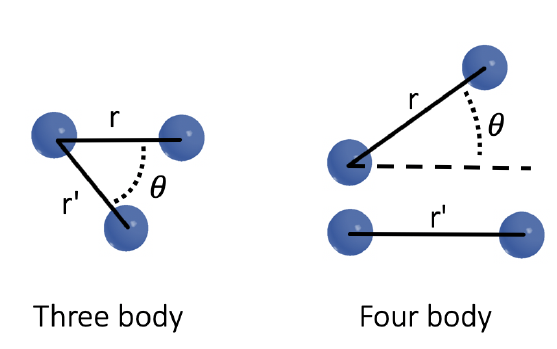
Figure 1. Geometry of three- and four-body correlations. The definition of the atomic coordinates in the pair-angle distribution function (PADF). Note the four-body term is insensitive to the distance between the two